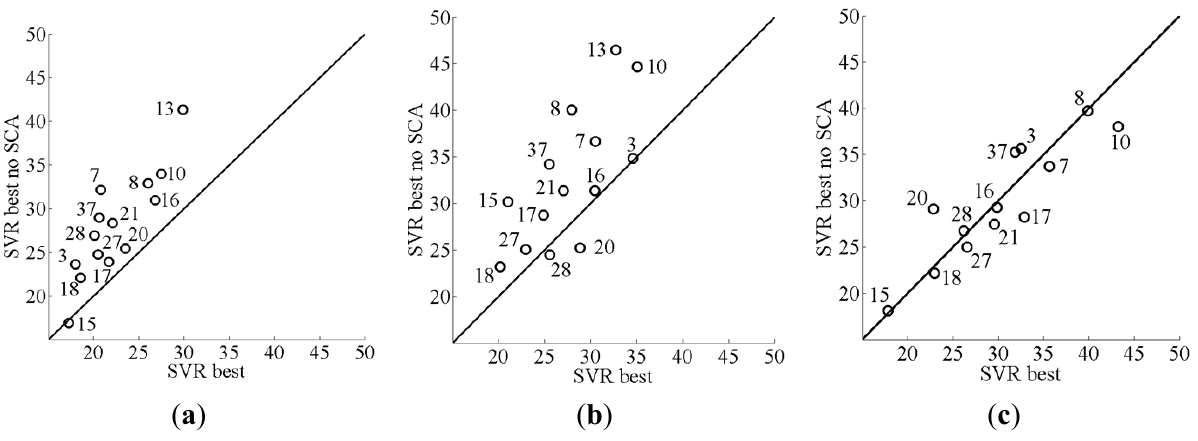
Figure 5. Comparison of the RMSE% obtained on the test set between the SVR method proposed ( x axis) against the simple method based only on the average discharge of the target month computed over 10 previous years. In the scatterplots ( a ), ( b ), and ( c ) the prediction lag is equal to one, three, and six months, respectively.